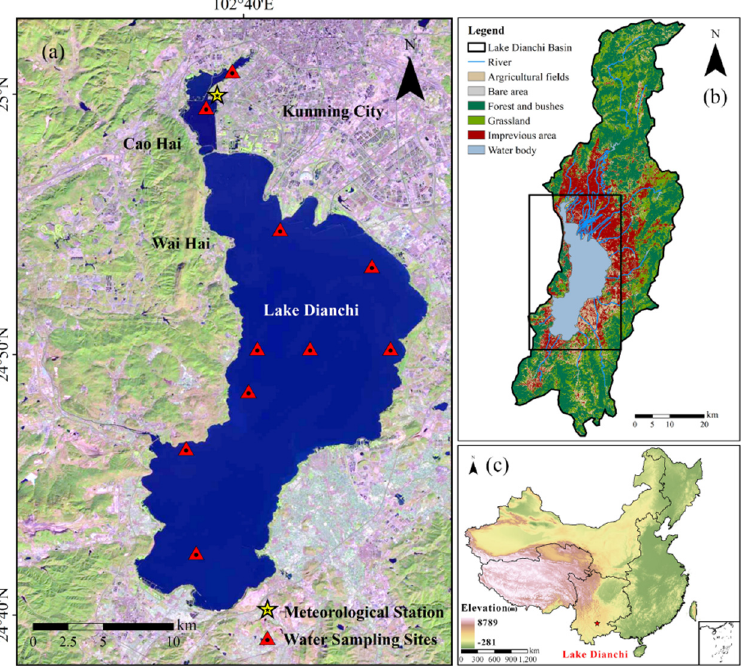
Figure 1. Distribution of sampling sites and rivers and the location of the Lake Dianchi Basin. ( a ) Distribution of sampling sites and the meteorological station in Kunming City. The yellow star marks the location of the national meteorological station. The red triangle marks the location of the sampling sites in Lake Dianchi. ( b ) Land use in the Lake Dianchi Basin. The black box indicates the location of Lake Dianchi. ( c ) Location of Lake Dianchi in China.